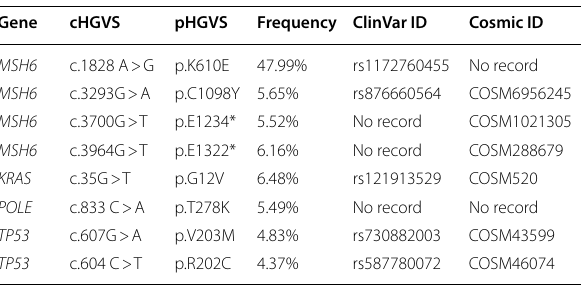
Table 1 Mutations in the tumor tissue identified by the 11-gene NGS